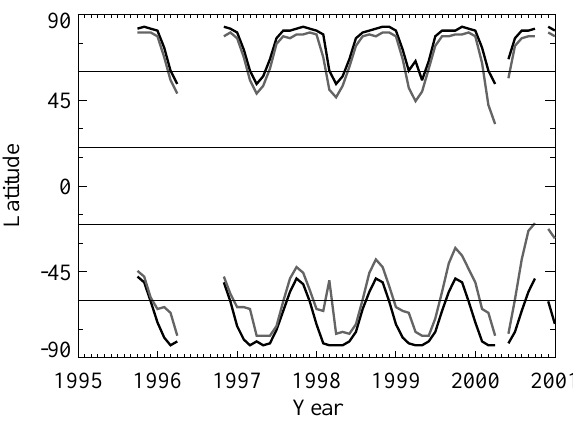
Fig. 11. Time-series of the maximum and minimum latitudes included in the GRAPE (black line) and GACP (grey line) datasets for the period covered by the GRAPE dataset. The thin horizontal lines indicate the north-south boundaries of the regions defined in Fig 8 at ± 20 ◦ and ± 60 ◦ .